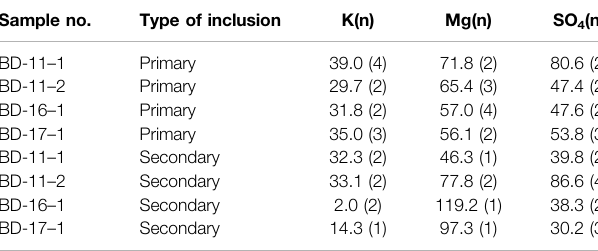
TABLE 3 | Chemical composition of halite fl uid inclusion (g/L). Sample